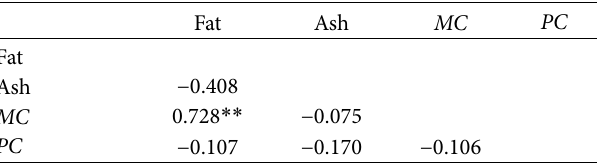
Table 6: Pearson correlation matrices of proximate composition of NSP flour